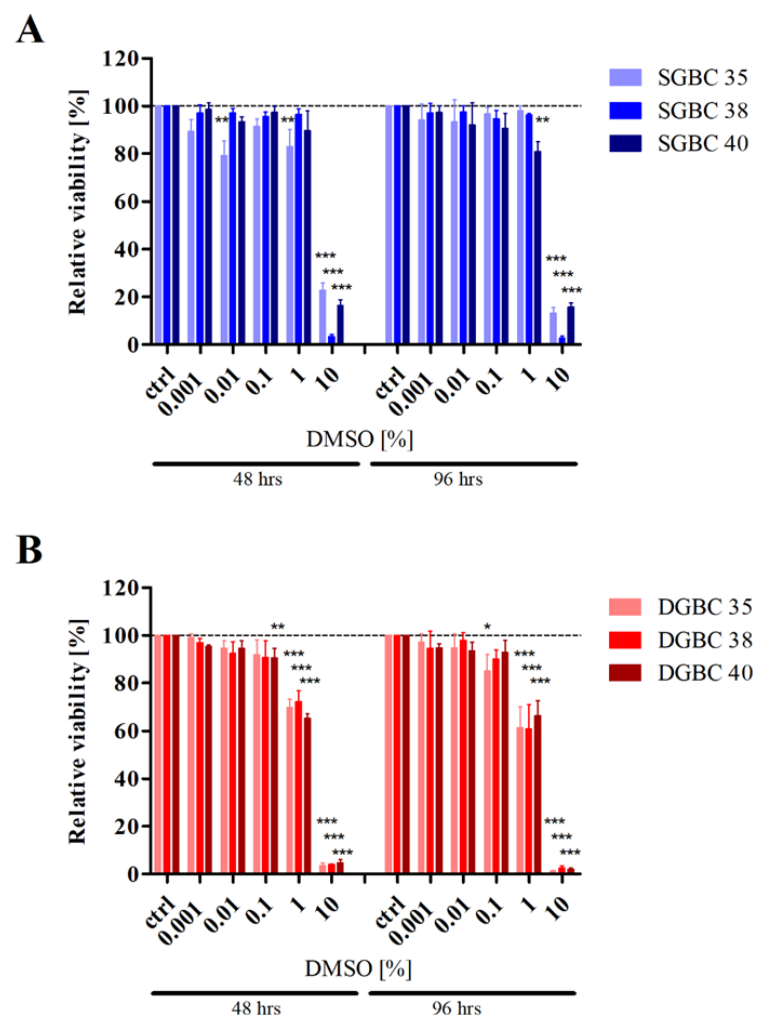
Figure 2. E ff ect of the solvent Dimethyl sulfoxide (DMSO) on metabolic activity of glioblastoma stem cell-like cells and their di ff erentiated progeny. ( A ) Glioblastoma stem cell-like cells (SGBCs) and ( B ) their di ff erentiated progeny (DGBCs) from three individual patients (35, 38 and 40) were stimulated with indicated percentages v / v of the solvent DMSO for 48 and 96 hours. The relative viability of the respective populations was normalized to untreated control populations (ctrl). The columns represent the mean and positive standard deviation of three independent experiments carried out in triplicates. Cell culture conditions and experimental setup were as previously described [70,74], statistical analysis was performed using a one-way ANOVA test, followed by the Tukey’s multiple comparison test; *, p ≤ 0.05; **, p ≤ 0.01; ***, p ≤ 0.001.